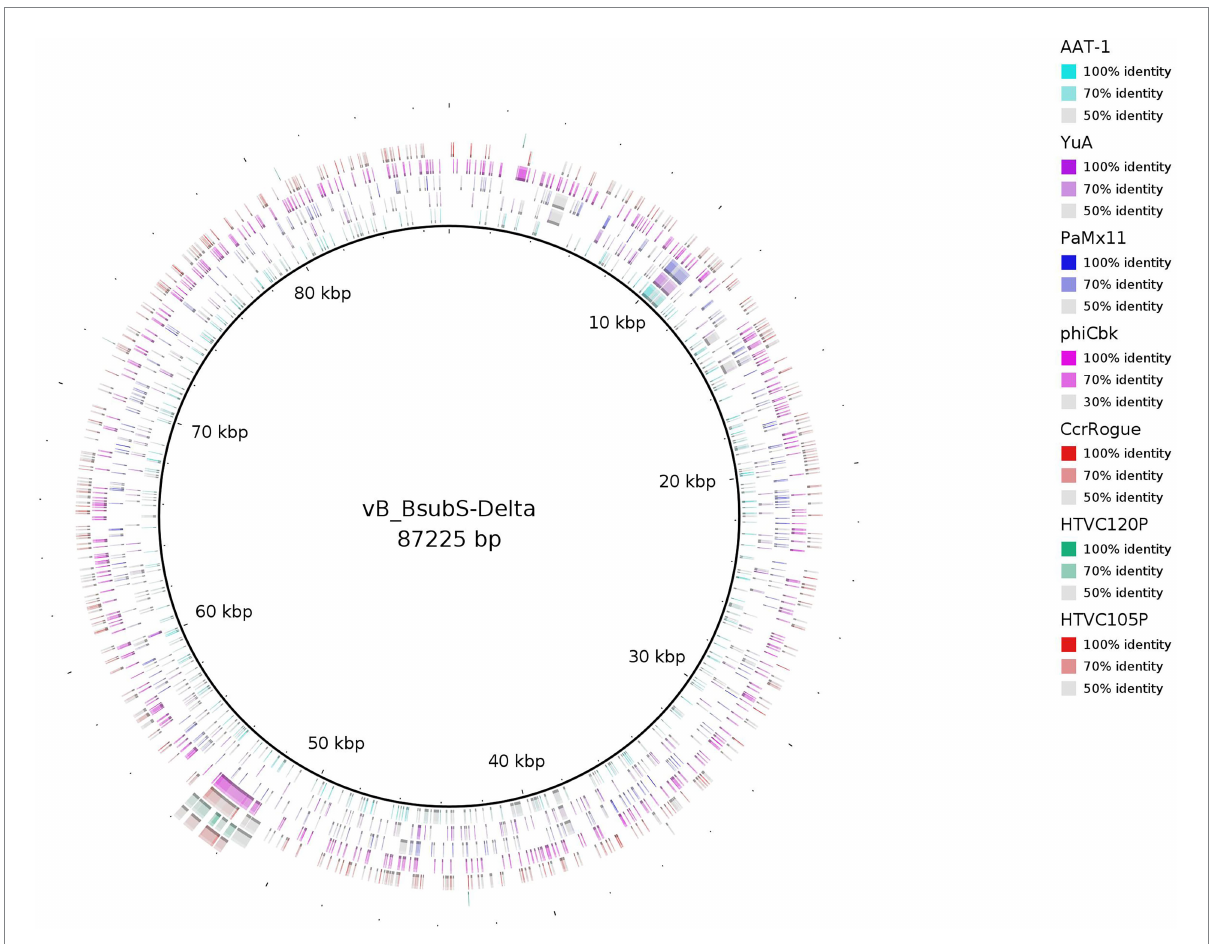
FIGURE 4 Comparative genome map of representatives from major phylogenetic clusters using Brevundimonas phage vB_BsubS-Delta as a reference. The percent amino acid identities of each phage relative to Brevundimonas phage vB_BsubS-Delta, as identified by tBLASTX analysis, are shown as different hues. Concentric rings correspond to phages listed in the legend, with the innermost ring corresponding to Pseudomonas phage AAT-1 and the outermost ring corresponding to Pelagibacter phage HTVC105P. Segments with percent identity below 50% are not